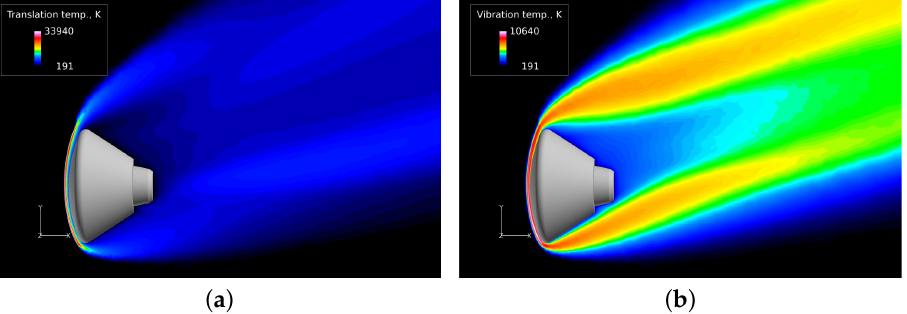
Figure 8. Temperature distributions around the ESA ARD at an altitude of 85 km ( x - y plane).